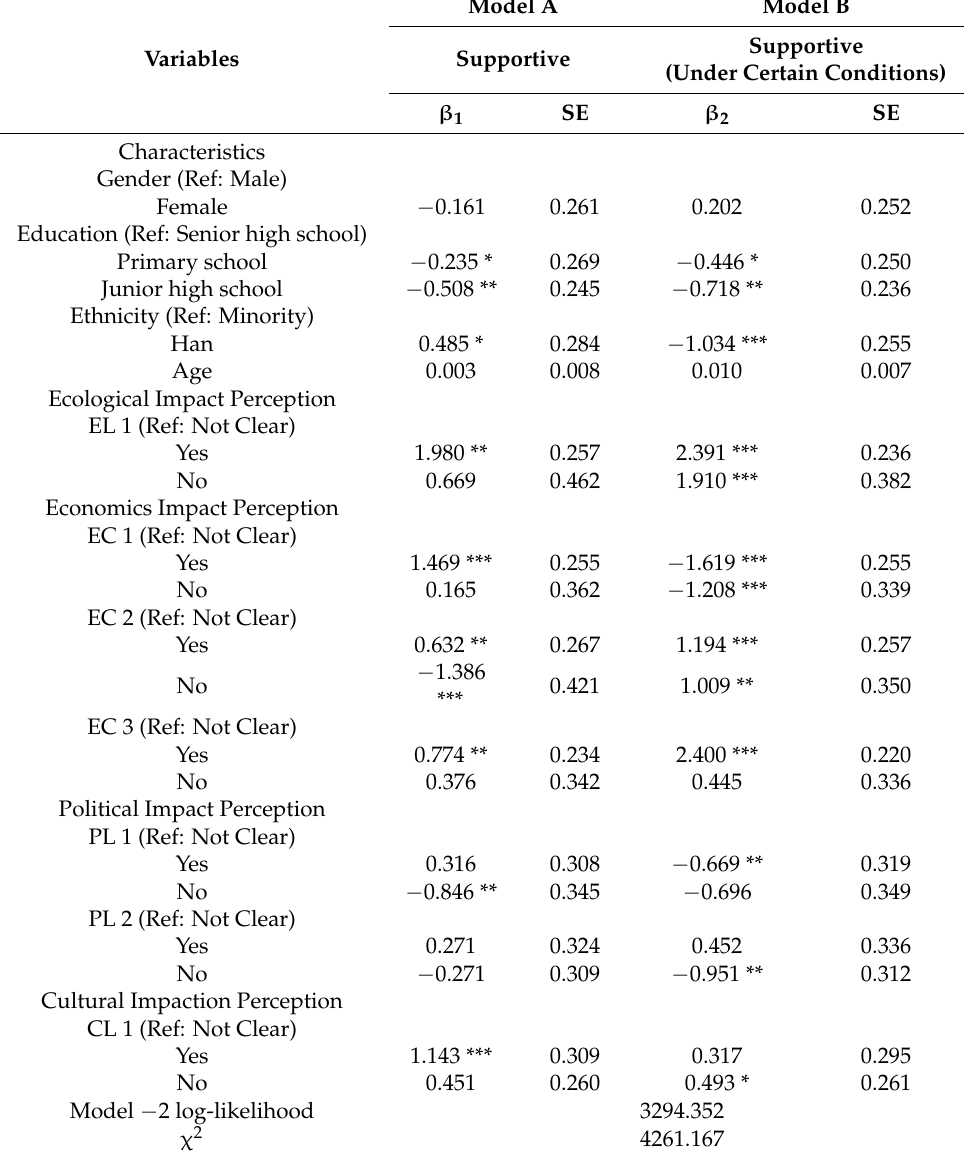
Table 3. Results of multinomial logistic